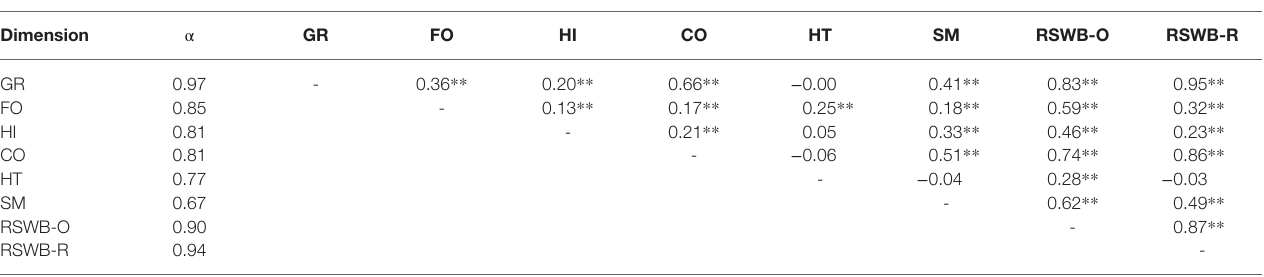
TABLE 4 | Intercorrelations and internal consistencies of the MI-RSWB-S. Dimension α